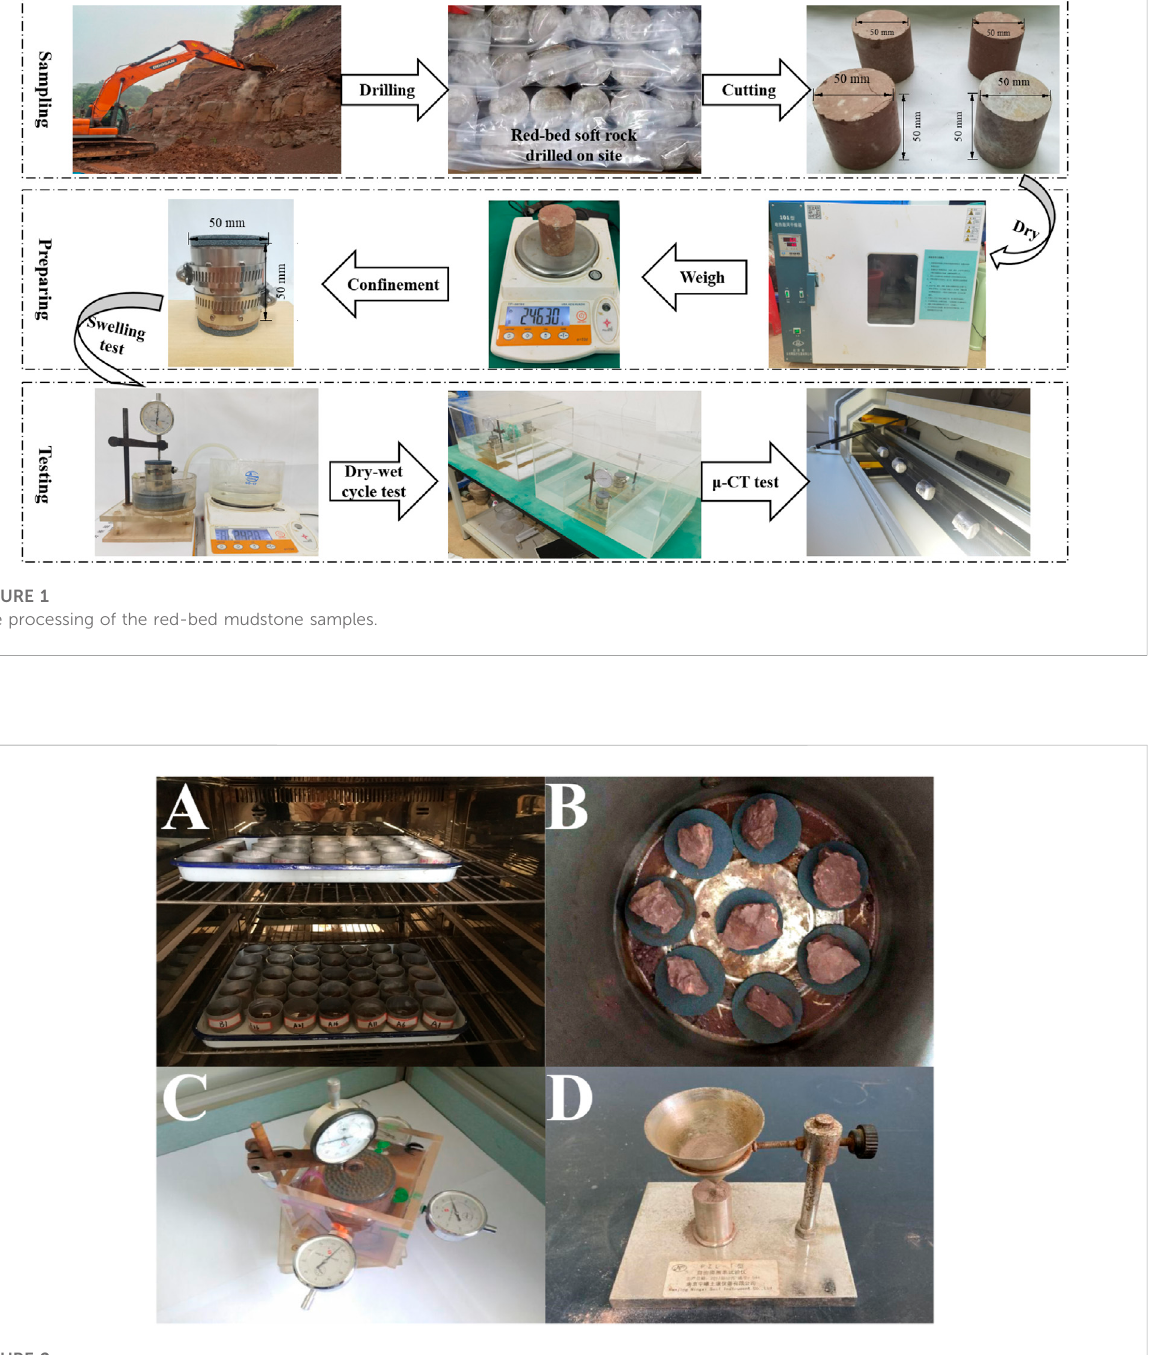
of the two end faces and the diameter error ( < 0.3 mm) along the height of the specimen should be strictly controlled. As shown in the third fi gure in Figure 1, a cylindrical sample (50 mm in diameter, 50 mm in height) could be obtained accordingly. To